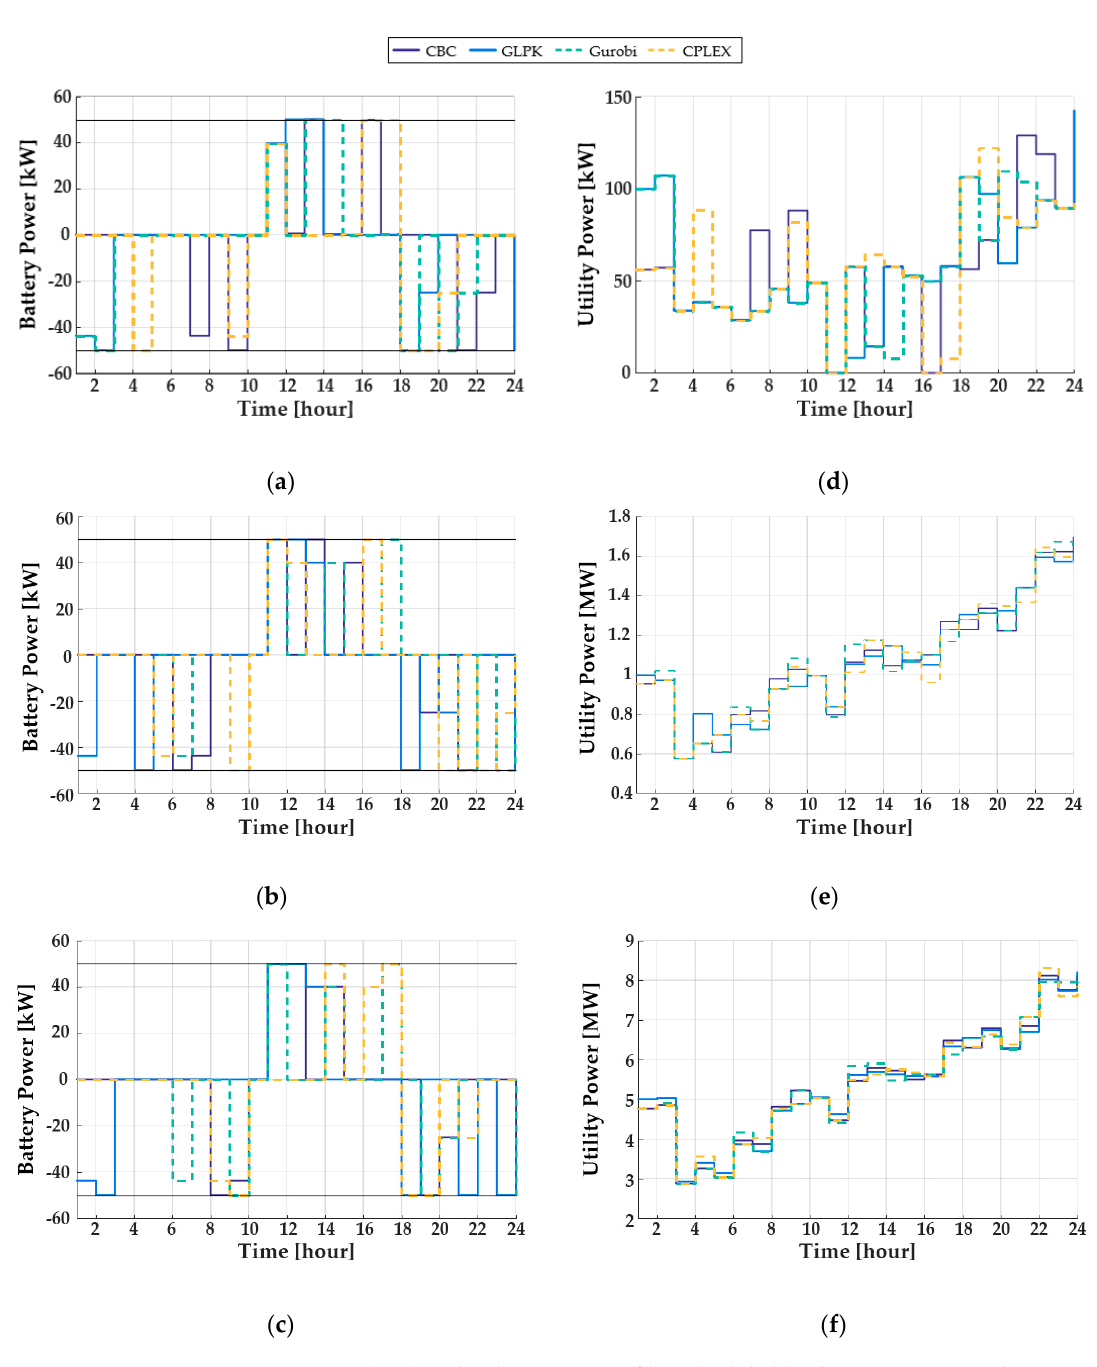
Figure 8. Energy storage system (ESS) and utility power profiles scheduled by the optimization solvers. ( a , d ) case 1: 6-bus system; ( b , e ) case 2: 33-bus system; ( c , f ) case 3: 123-bus system.